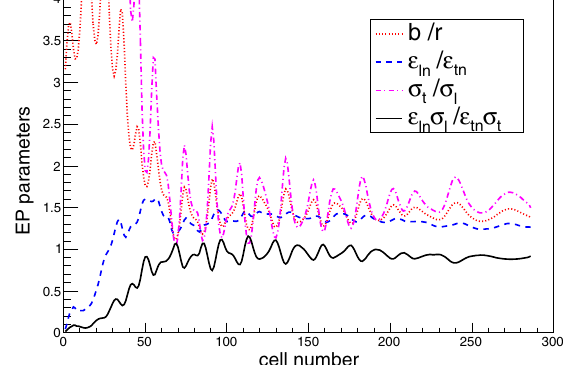
FIG. 4. Parameters related to the equipartitioning condition (EP parameters). When the equipartitioning condition holds, the solid line should be one.